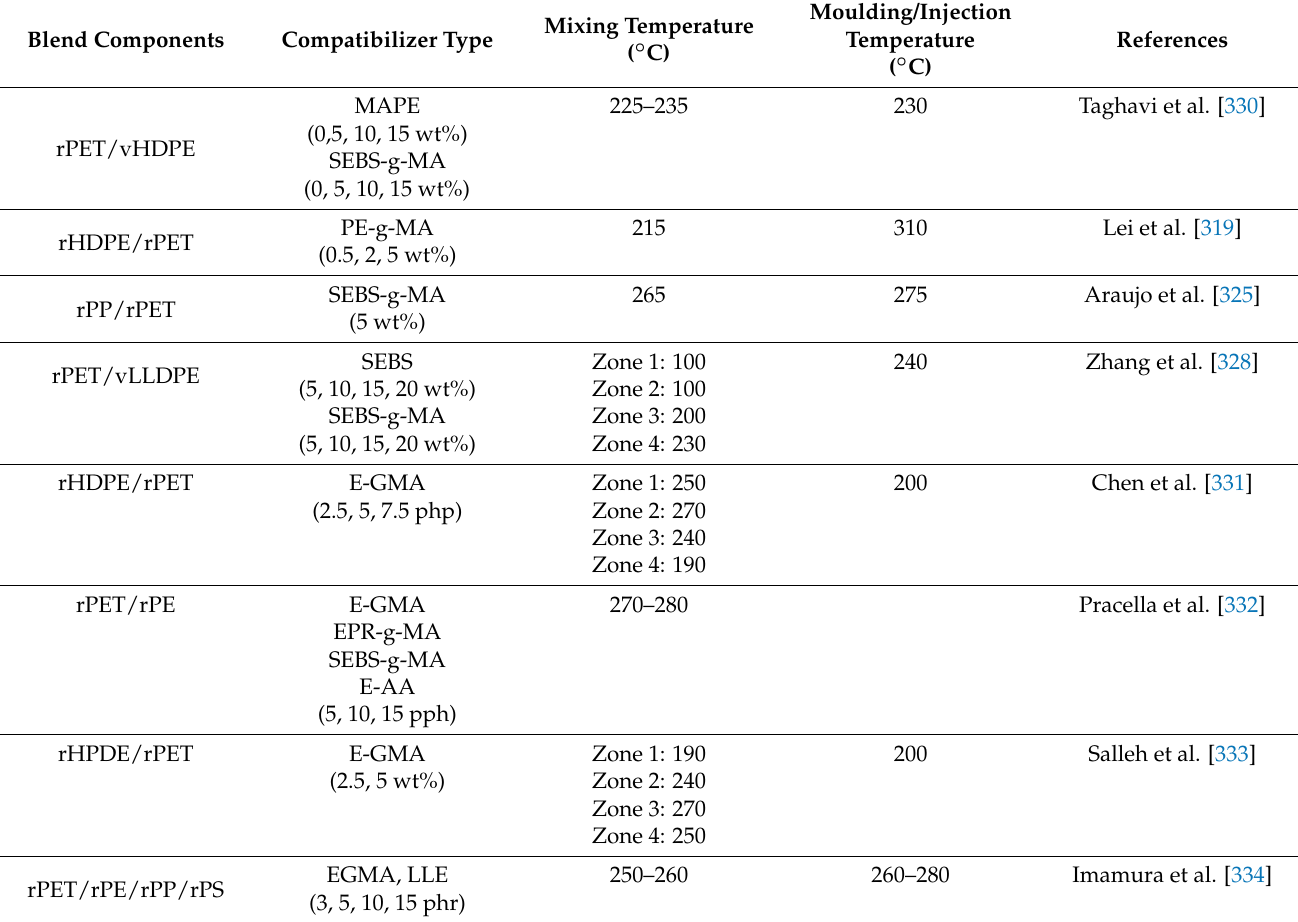
Table 5. Literature summary on preparing PO/rPET